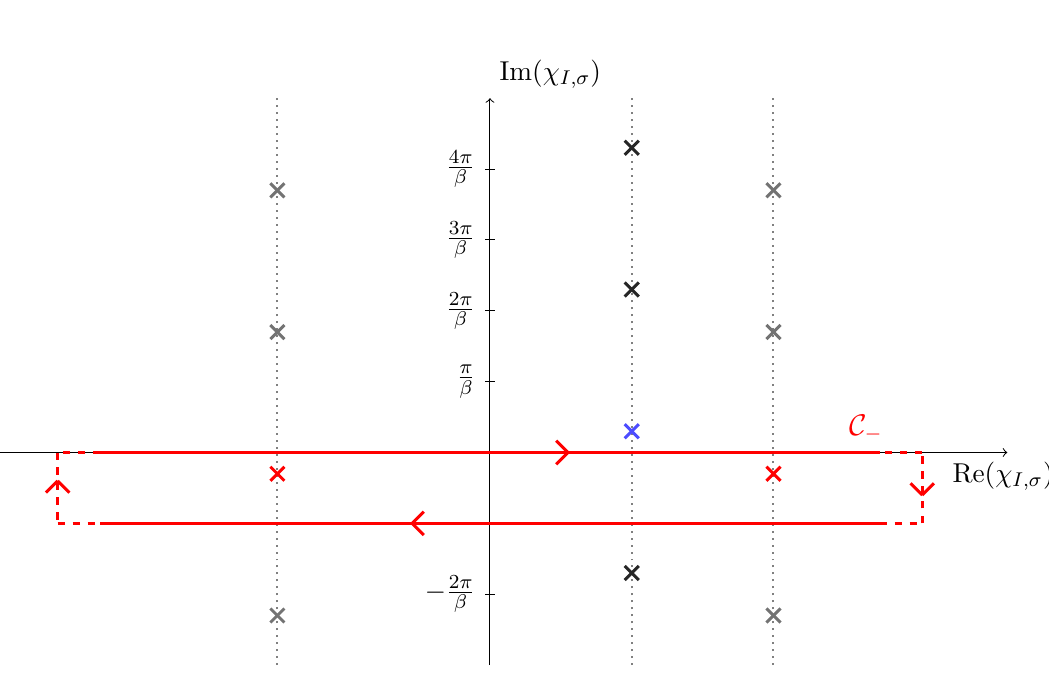
Figure 6 . The contour C (cid:0) for the case of the [1 ; 2] surface operator in SU(3) at